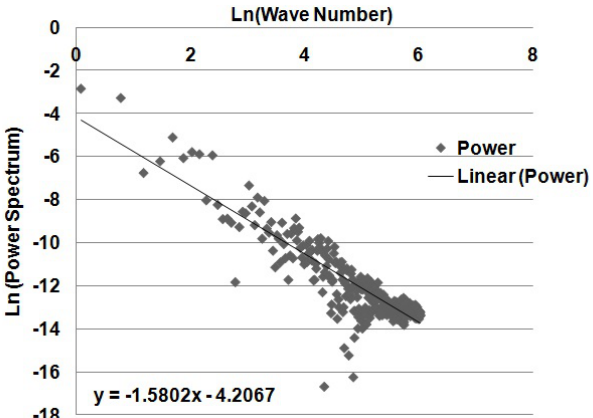
Fig. 5. Log-log plot of power spectrum of heat production data vs wave number for the Nissho pluton, Hidaka terrain (Hokkaido, Japan). Best linear fit gives scaling exponent of 1.6, indicating frac- tal behavior in the data set. This figure also shows a good correlation between adjacent data